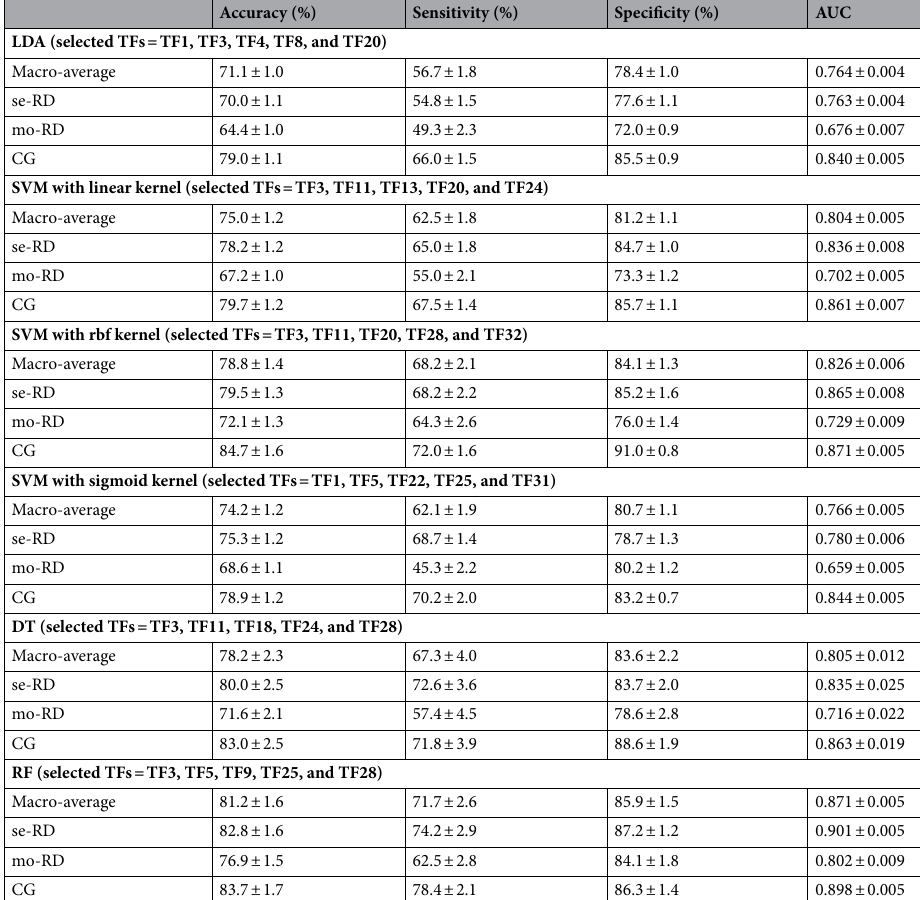
Table 3. Performance of each classification attempt in discriminating between the three groups in T1-weighted in-phase imaging (T1WI IP). TF texture feature, DT decision tree, LDA linear discriminant analysis, SVM support vector machine, RF random forest classifier, AUC area under the curve, se-RD severe renal dysfunction (estimated glomerular filtration rate [eGFR] < 30 mL/min/1.73 m 2 , i.e., CKD stage G4–5), group (eGFR ≥ 60 mL/min/1.73 m 2 , i.e., CKD stage G1–2). Feature name codes are as follows: TF1 = 10th percentile, TF3 = energy, TF4 = entropy, TF5 = interquartile range, TF8 = median, TF9 = robust mean absolute deviation, TF11 = total energy, TF13 = difference average, TF18 = joint energy, TF20 = maximum probability, TF22 = dependence non uniformity, TF24 = dependence variance, TF25 = gray level non uniformity (gray-level dependence matrix), TF28 = gray level non uniformity (gray-level run length matrix), TF31 = run entropy, TF32 = run length non uniformity. The data are expressed as means ± standard